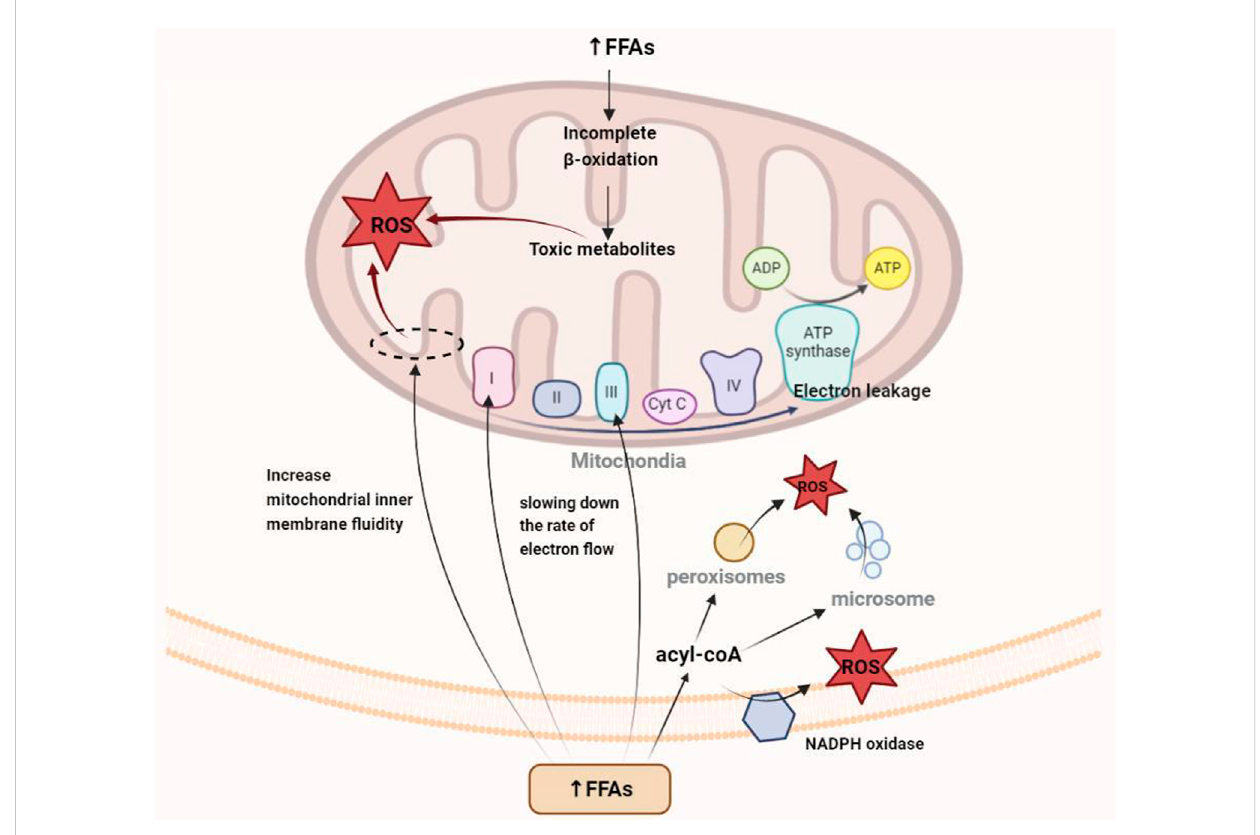
FIGURE 2 Mechanism of oxidative stress caused by the increase in free fatty acids in